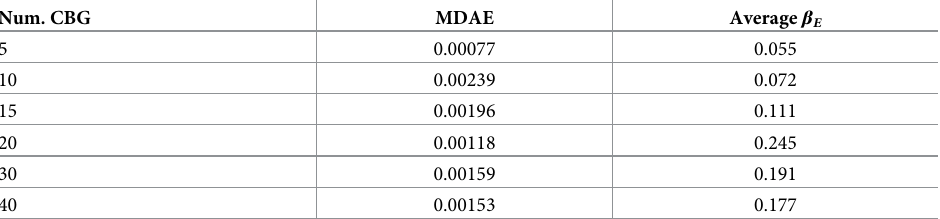
Table 4. The MDAE does not vary significantly for different sizes of subsampled graphs. The inference procedure found values of β E which fit the observed data well in each case. Num. CBG